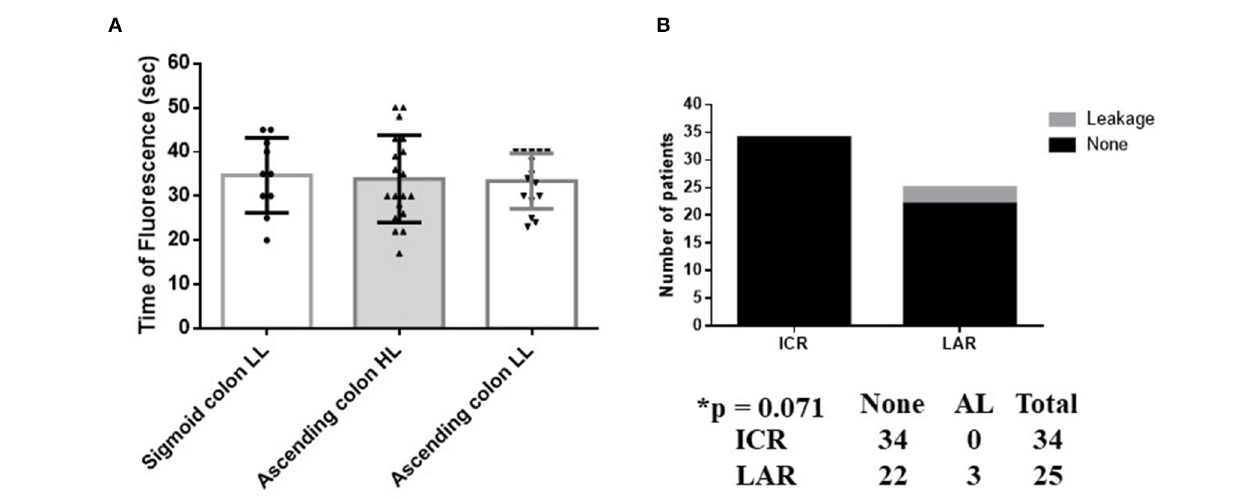
FIGURE 5 | Blood flow and anastomotic leakage in ICR vs AR. (A) Comparison of the FT between the ascending and sigmoid colon with preservation of the left colic artery. The FT of the sigmoid colon with LL of the IMA (34.7 ± 8.5s) is similar to the FT of the ascending colon with HL or LL of the ICA (33.9 ± 9.9s and 33.4 ± 6.3s, respectively) ( p = 0.932). (B) Association between AL and surgery type. The occurrence of AL in LAL did not represent a significant difference vs. ICR ( p = 0.071). Calculated by Fisher’s exact 2 × 2 contingency table. HL, high ligation; LL, low ligation; ICR, ileocecal resection; LAL, low anterior rectal